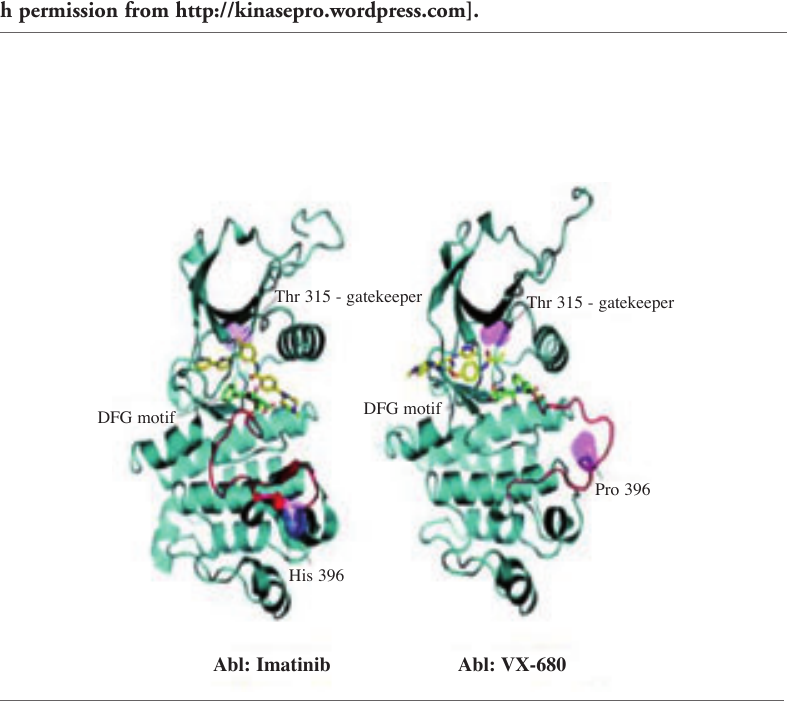
Figure 3. Structure of Abl domain kinase bound to imatinib (left) and to VX-680 (right). [Reprinted and adapted with permission of AACR from: Young MA, et al. Structure of the kinase domain of an imatinib-resistant Abl mutant in complex with the Aurora kinase inhibitor VX-680. Cancer Res 2006 Jan